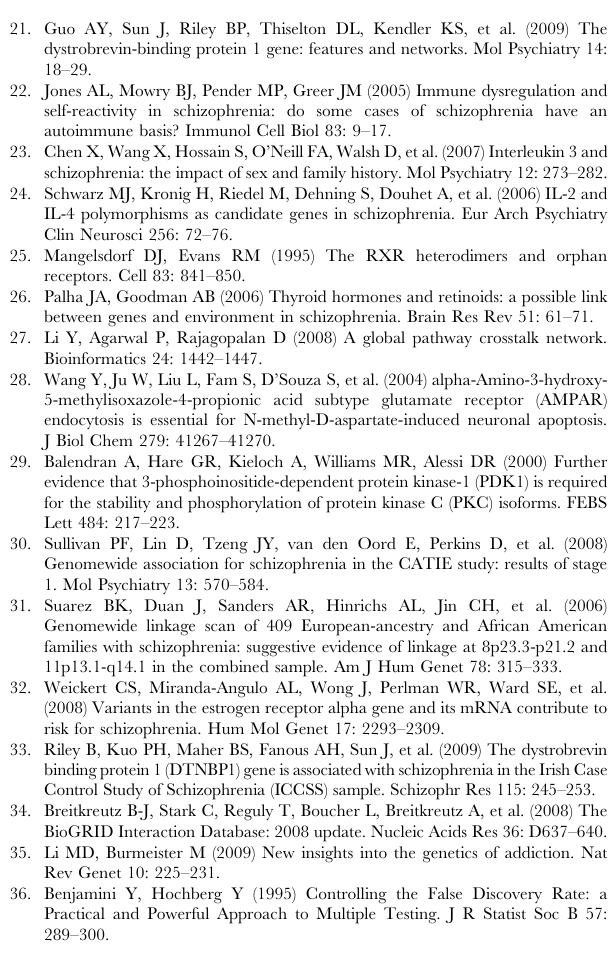
Table S5 Information of 16 genes in association studies and GWA studies. Figure S1 Degree distribution of five gene sets. Y-axis represents the proportion of proteins having a specific degree. Figure S2 Shortest-path distance of five gene sets. (A) Charac- teristic shortest-path distance distribution. Y-axis is the proportion of proteins having a specific characteristic shortest-path distance. The average characteristic shortest-path distance and its empirical P value for randomness from the human interactome are shown in the table inside. (B) Global centrality distribution. Y-axis is the proportion of proteins having a specific global centrality. Vertical line represents the average global centrality of each gene set, which is also summarized in the inside of the figure. Figure S3 Cancer-specific network. Cancer genes are labeled in red and non-cancer genes in blue. Node area corresponds to its degree in the human interactome. Node shape indicates its cellular location: ellipse for cytoplasm, diamond for extracellular space, triangle for nucleus, square for plasma membrane, and hexagon for unknown location.